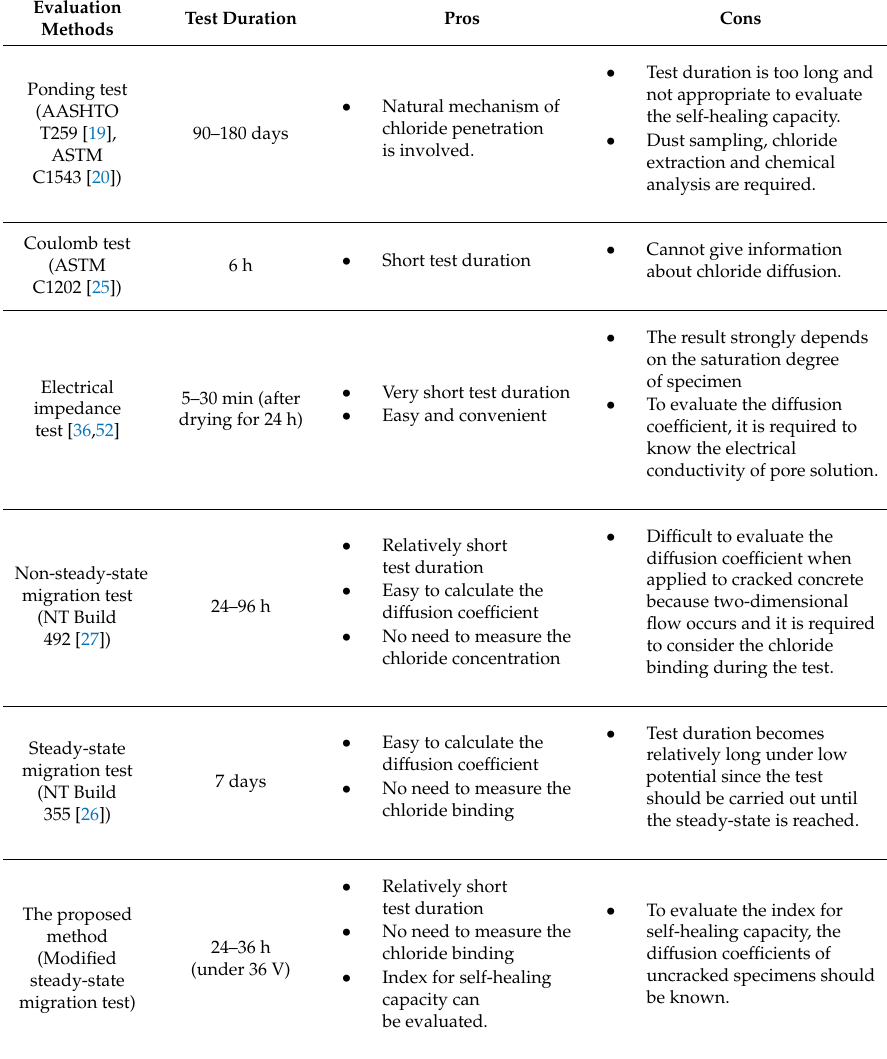
Table 5. Comparison of evaluation methods of chloride penetration resistance recovery due to